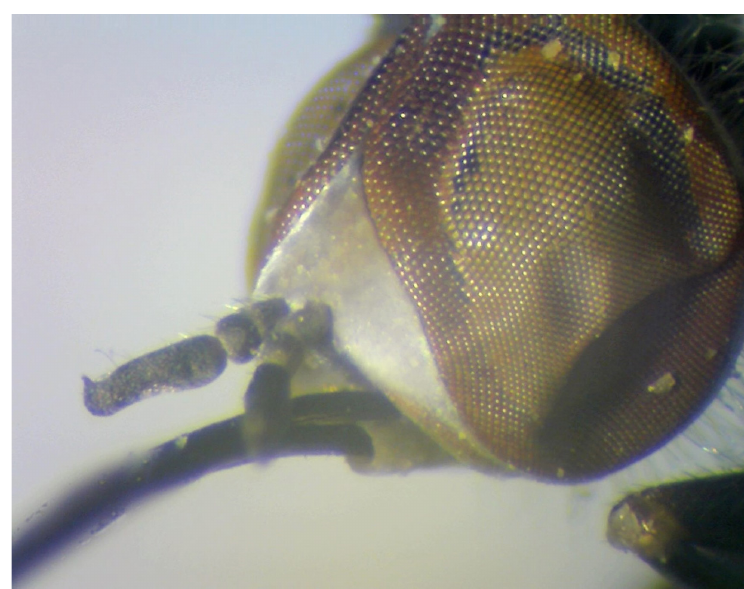
Fig. 14. Protypusia negevi (Zaitzev, 1996) gen. et comb. nov.,